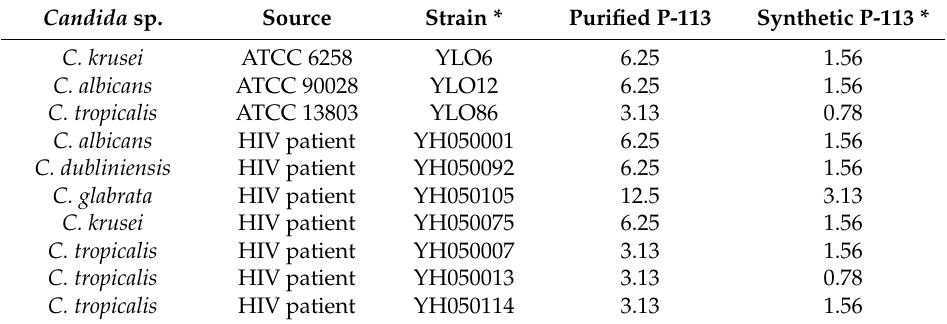
Table 1. Minimum inhibitory concentration (MIC) values of P-113 for tested Candida strains ( µ g/mL). Candida